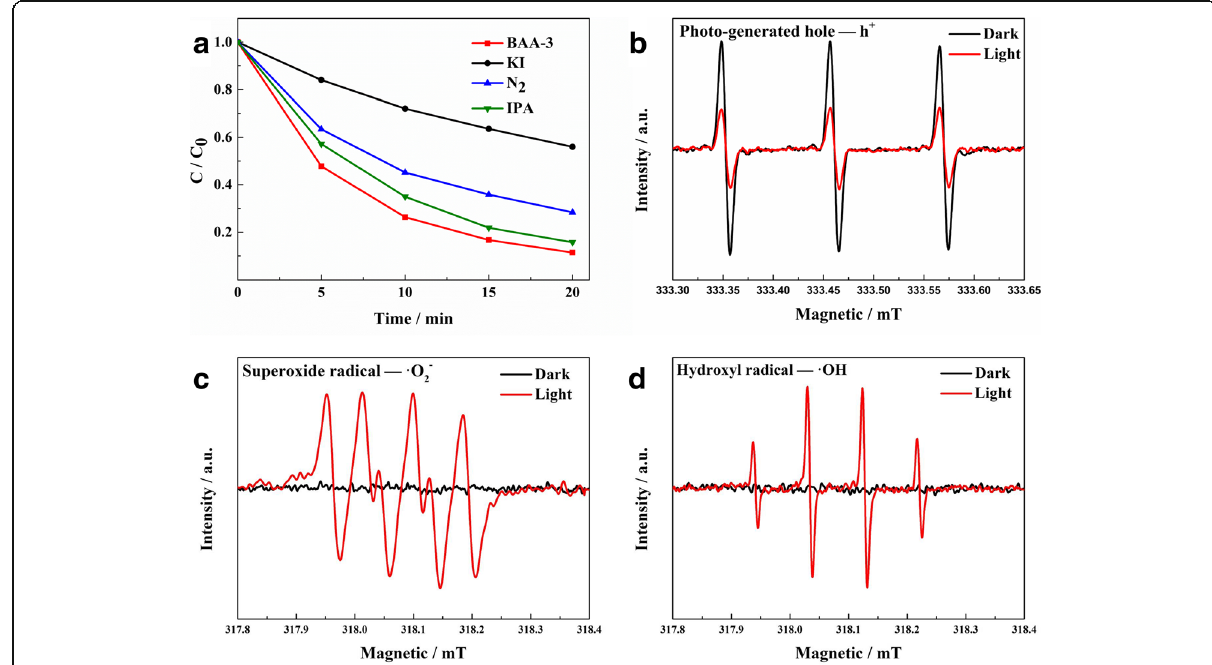
Fig. 5 Results from the radical trapping experiment in the presence of BAA-15 ( a ) and the EPR spectra of the photo-generated hole ( b ), ·O 2 − radical ( c ), and ·OH radical ( d )